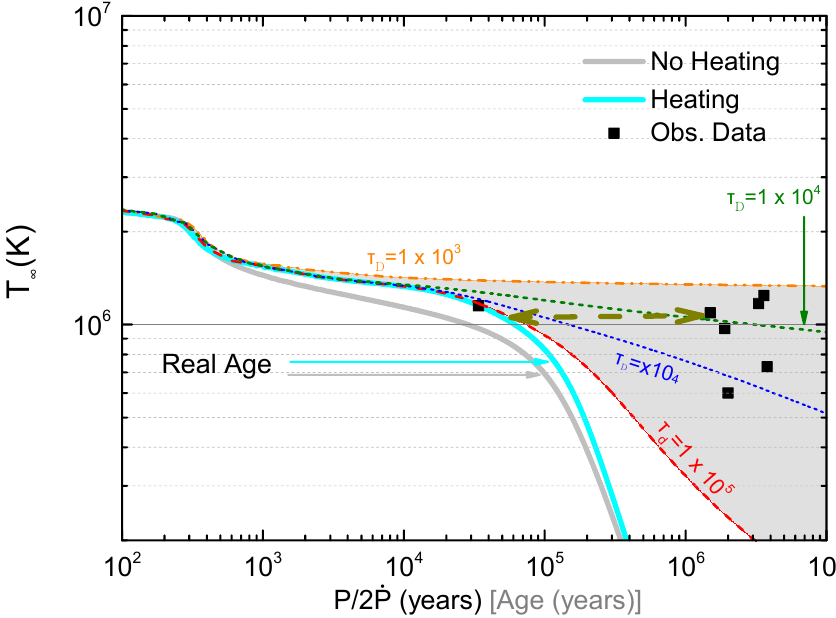
Figure 10. Same as Figure 9 but with a heating source of H ≈ 10 16 erg s − 1 cm − 3 uniformly applied to the crust for the first 10 4 years. Curves accompanied by the indicated τ D represent the temperature as a function of the spin-down age ( P /2 ˙ P ). The shaded area represents where the curves for magnetic field evolutions with τ D = 10 3 − 5 years lie. We also indicate, for the sake of example, the difference between the spin-down age and real age (in the presence of heating) for the XDINNS